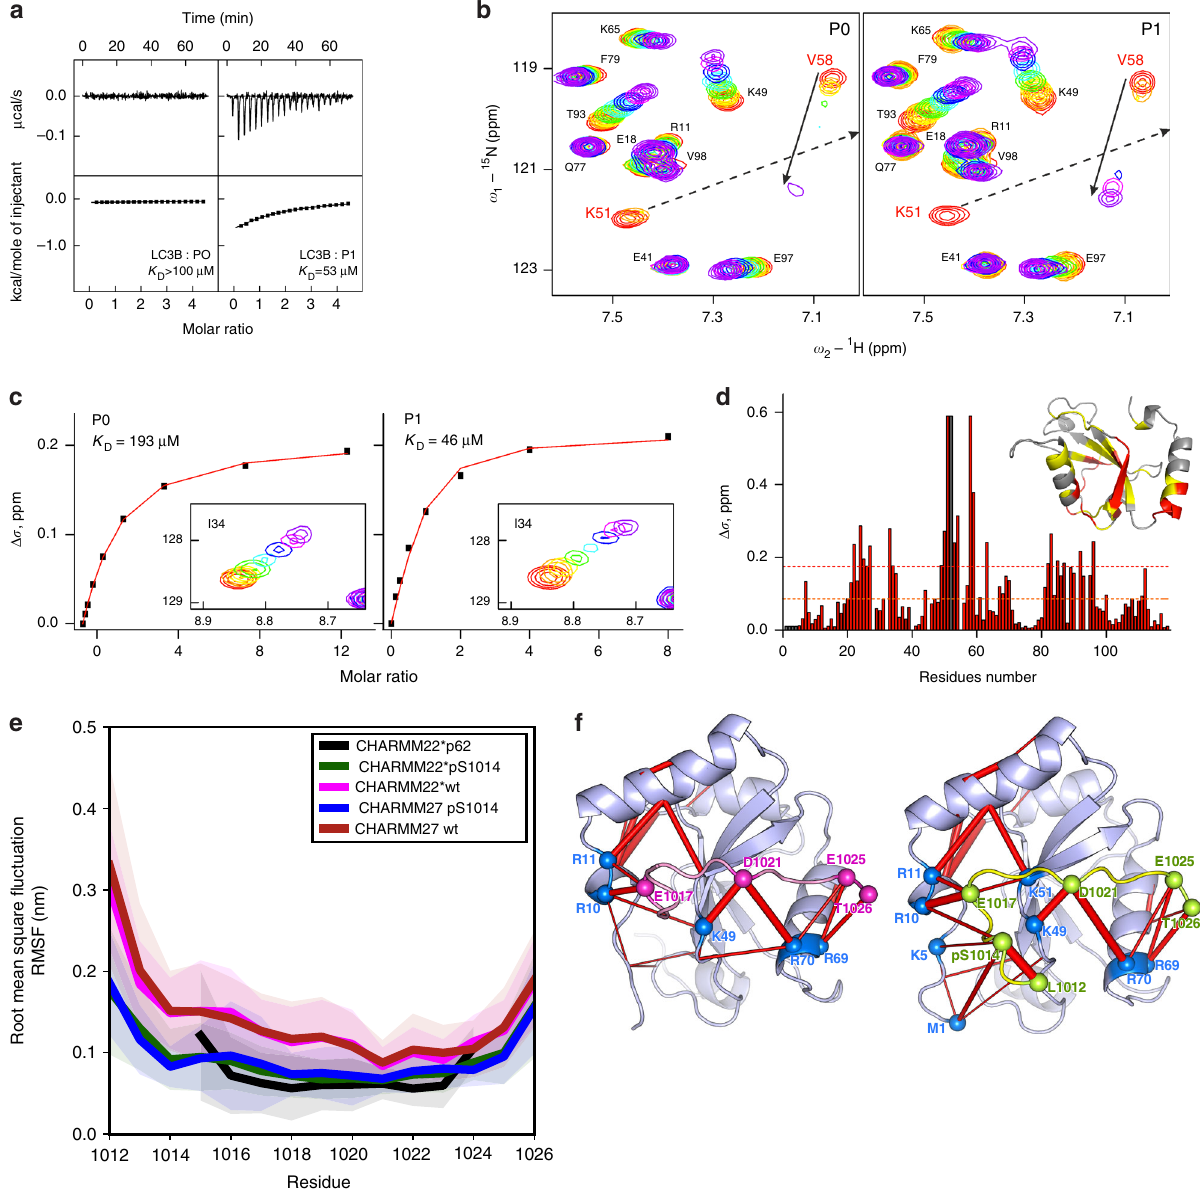
Fig. 4 S1014-AMBRA1 phosphorylation allows AMBRA1 – LC3B binding. a ITC titrations of unmodi fi ed AMBRA1-LIR peptide (P0) compared with those of S1014-phosphorylated AMBRA1-LIR peptide (P1) into LC3B protein. The measurements were performed at 35 °C. Measured/estimated K D values are indicated for each interaction. b Representative sections of HSQC spectra for 15 N-labelled LC3B upon titration with P0 and P1. Both plots show fi ngerprint regions of the LC3B spectra (around HN resonance of K51). Molar ratios of protein/peptide are rainbow coloured (1:0, 1:0.125, 1:0.25, 1:0.5, 1:1, 1:2, 1:4 and 1:8; from red to violet) for each titration step. Arrows indicate the CSP for K51 and V58 HN backbone resonances. c K D values calculated for the LC3B residue I34 upon titration with P0 and P1. Original CSP values are shown as black squares and the resulting fi t is given as a red line in each plot. The original HSQC areas around I34 HN resonance are shown as a box under fi tted curves. d CSP values ( Δ δ ) at the last titration stages for LC3B protein are plotted against residues numbers. The orange dashed line indicates the standard deviations ( σ ) over all residues within each dataset, and the red dashed line indicates double σ values. The CSP values mapped on the LC3B protein structure (ribbon diagrams, PDB ID 1UGM) are shown in the upper right corner. Residues with small ( Δ δ < σ ), intermediate ( σ < Δ δ < 2 σ ) or strong ( 2 σ < Δ δ ) CSPs are marked in grey, yellow and red, respectively. e The root mean square fl uctuation (RMSF) per residue of AMBRA1 decreases after S1014 phosphorylation (blue, green lines) compared to wt (magenta, red lines) and control P62 (black line) and is persistent with CHARMM22* (black, green and magenta lines) and CHARMM27 (blue and red lines) force fi elds. Shaded area corresponds to 1 σ . f Superimposition of highly populated (>20%) electrostatic interactions (red bars, thickness indicates occurrence) over the LC3B/ AMBRA1-LIR structure. Interactions identi fi ed between residues of S1014-phosphorylated AMBRA1-LIR (right panel) and LC3B are identi fi ed by spheres and reproduced on the wt (left panel). Similar patterns were seen for simulations using CHARMM22* (shown here) and CHARMM27 force fi